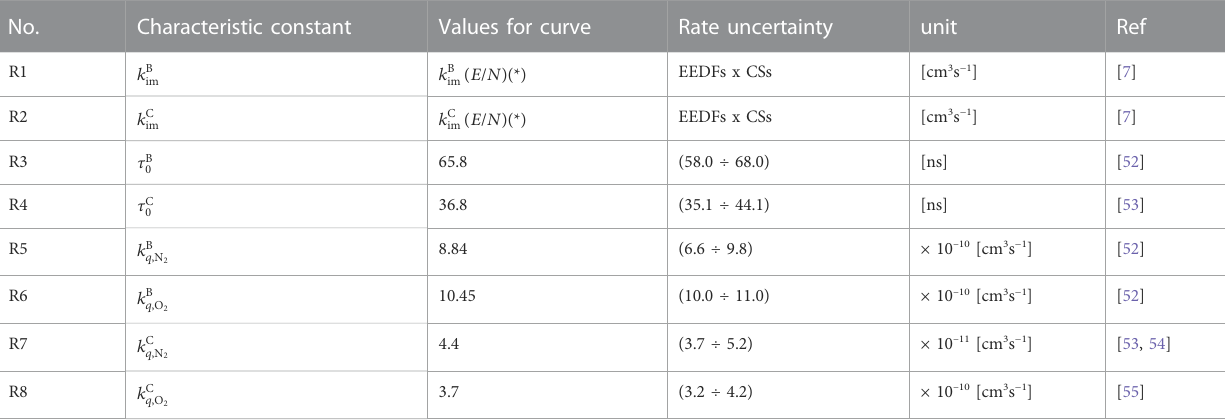
TABLE 2 Reaction rate constants and their uncertainties as used in the kinetic model. No.